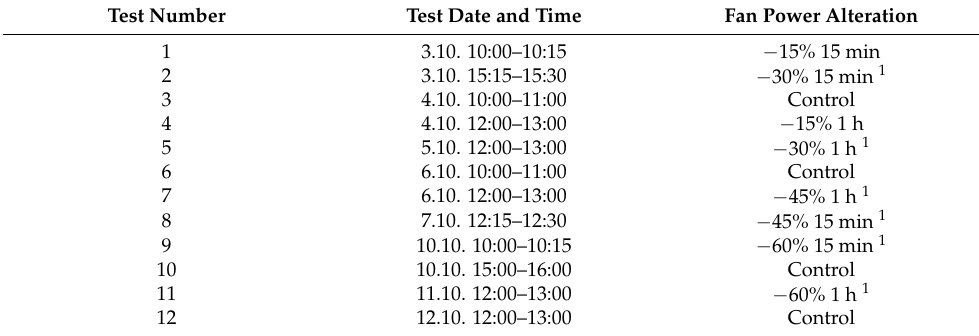
Table 2. The planned test schedule.